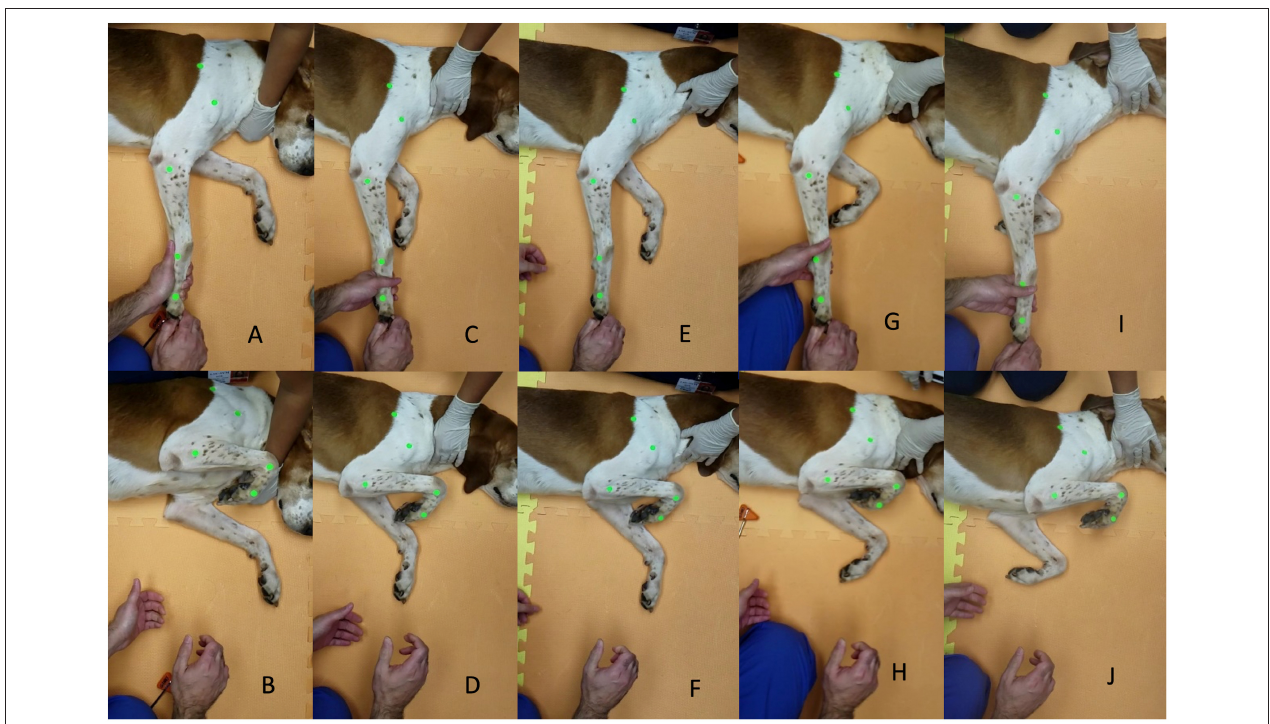
FIGURE 2 | (A–J) Example of testing thoracic limb withdrawal at the start of the reflex and end of the reflex, respectively, for awake timepoint (A,B) , 15min sedation timepoint (C,D) , 30min sedation timepoint (E,F) , 15min reversal timepoint (G,H) , and 30min reversal timepoint (I,J) .